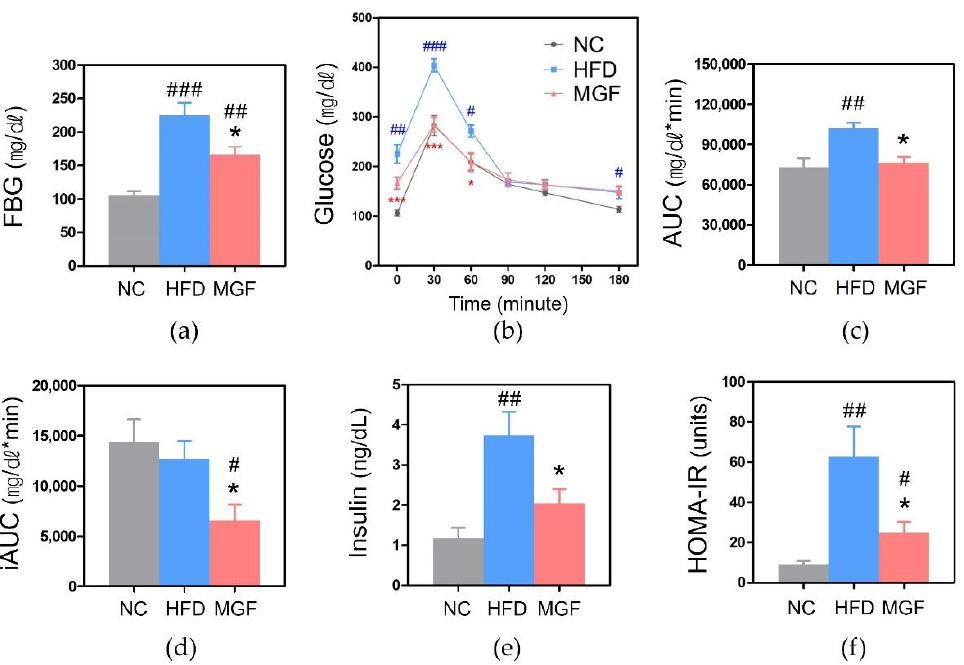
Figure 4. Glucose-metabolism-related outcomes. ( a ) Fasting blood glucose (FBG). ( b ) Oral glucose tolerance test (OGTT). ( c ) AUC of OGTT. ( d ) iAUC of OGTT. ( e ) Serum insulin level. ( f ) HOMA-IR. Data are expressed as mean ± standard error of mean. # p < 0.05, ## p < 0.01, and ### p < 0.001 indicate the results of comparison with the NC group, and * p < 0.05 and *** p < 0.001 indicate the results of comparison with the HFD group. NC, normal chow; HFD, high-fat diet; MGF, HFD + MGF 150 mg/kg/day; MGF, mangiferin; FBG, fasting blood glucose; AUC, area under the curve; iAUC, incremental area under the curve; OGTT, oral glucose tolerance test; HOMA-IR, homeostatic model assessment for insulin resistance.